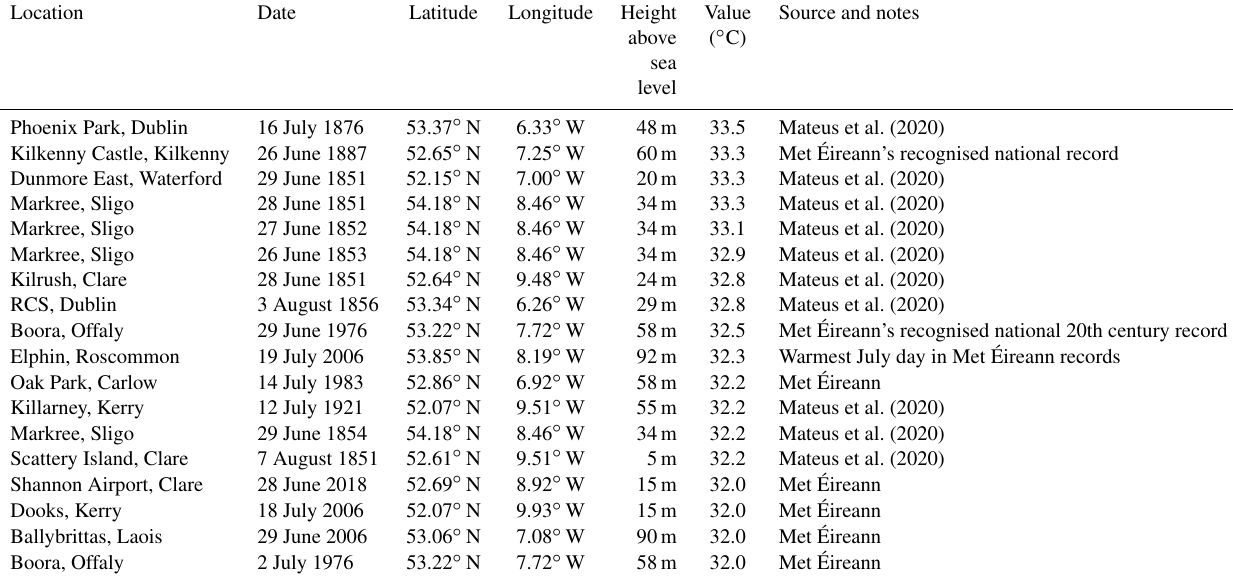
Table 2. Notable heat extremes in available records from the Republic of Ireland over the instrumental record sourced from Met Éireann’s website and available digital records, including the recently rescued early holdings from Mateus et al. (2020). The table includes all records that exceed 32 ◦ C, at least one of which must plausibly constitute the robust national record.